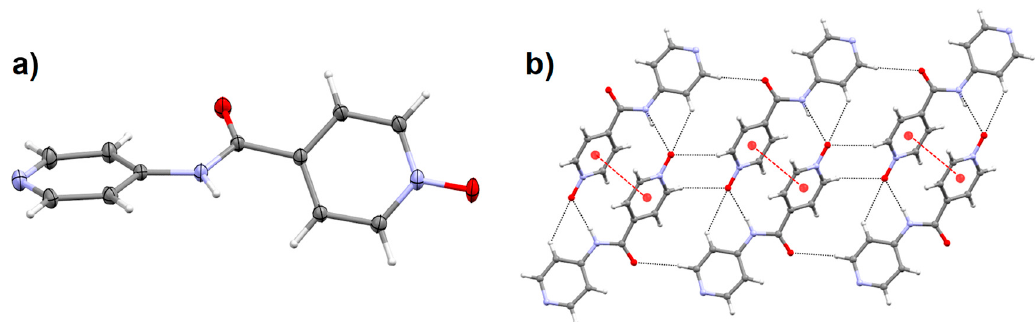
Figure 4. ( a ) Crystal structure of INO and ( b ) interaction of individual dimers via various non-bonding interactions; black dotted lines indicate hydrogen bonding and red dotted lines represent the π – π interactions.